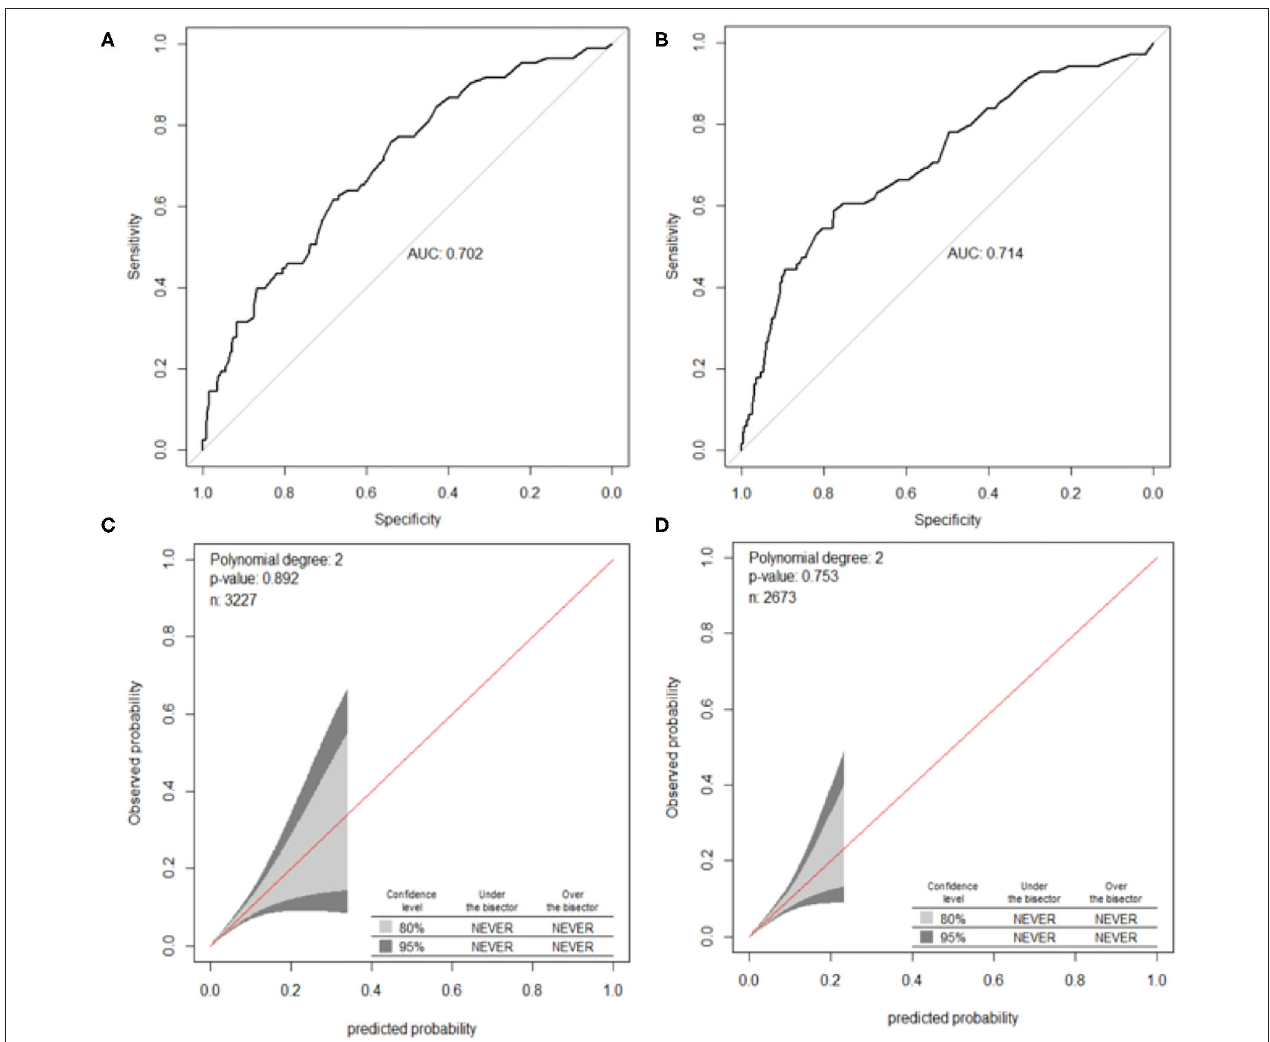
FIGURE 5 | ROC curves and calibration plots of the nomogram for OLGA stages III–IV. (A) ROC curve in the training cohort, (B) ROC curve in the validation cohort, (C) calibration plot in the training cohort, and (D) calibration plot in the validation cohort. OLGA, operative link for gastritis assessment; ROC, receiver operating characteristic curve; AUC, area under the